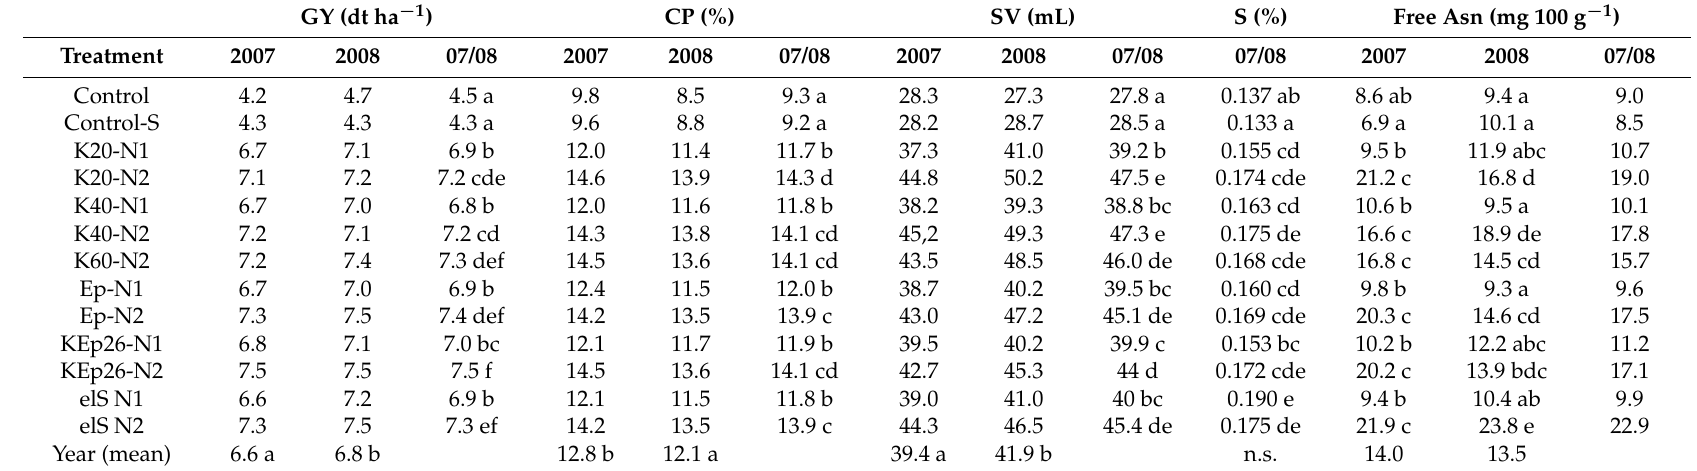
Table 7. Grain yield and grain quality traits of winter wheat cultivar Enorm of the S trial dependent on N and S fertilization and